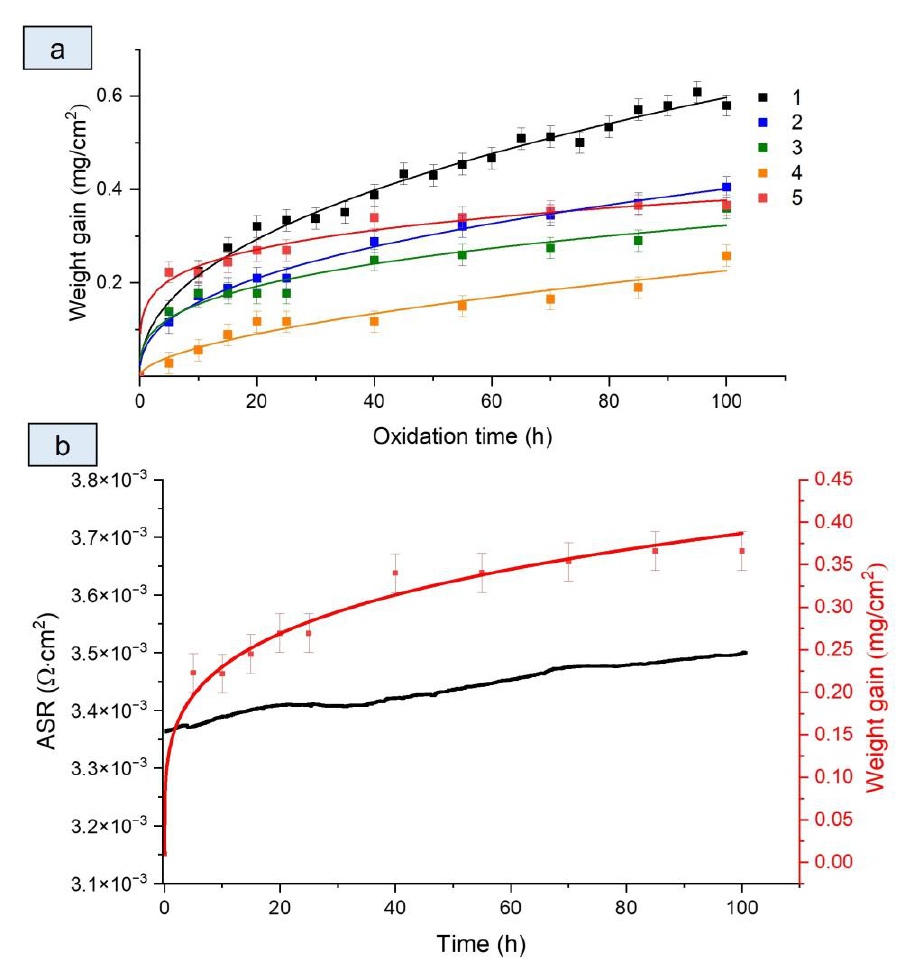
Figure 4. Dependences of sample weight on time of the heat resistance test ( a ) (1—bare Cr-Fe stainless steel; 2— δ Co/ δ Mn = 3.0/1.0 µ m; 3— δ Co/ δ Mn = 3.0/1.5 µ m; 4— δ Co/ δ Mn = 1.0/0.5 µ m; 5— δ Co/ δ Mn = 1.5/0.5 µ m) and dependence of specific resistance of a coated Fe-Cr steel sample on time ( b ).